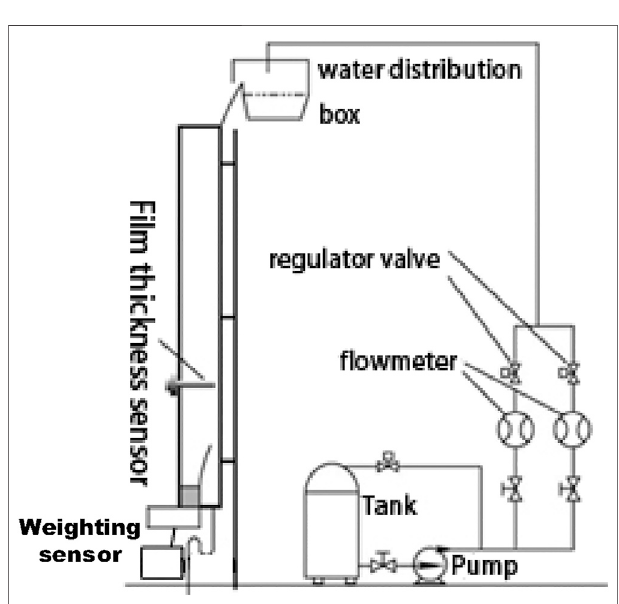
FIGURE 2 | Schematic of WAFT experiment facility.